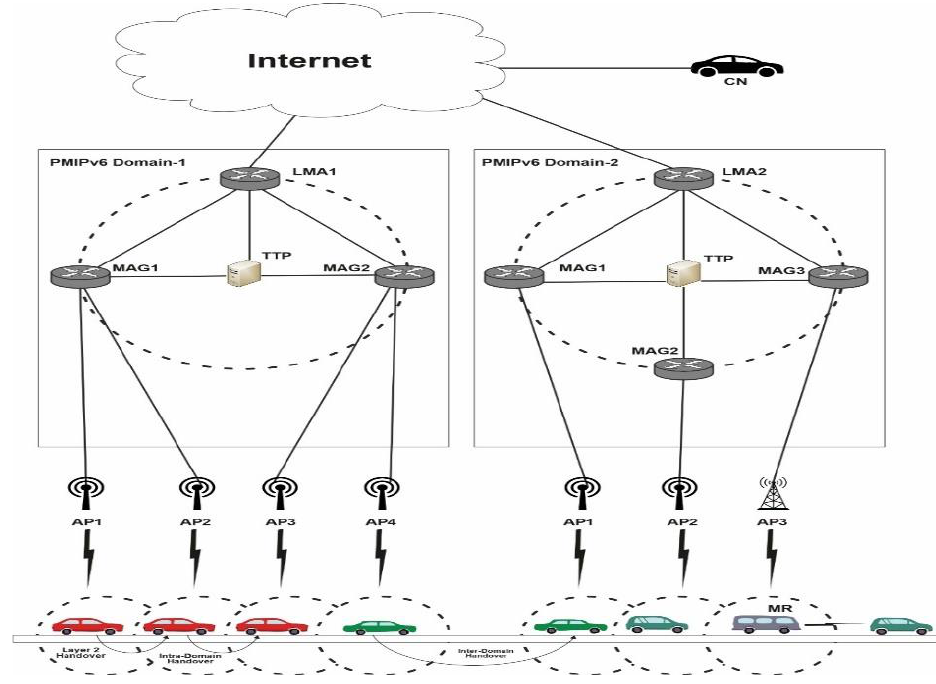
Figure 3. PMIPv6 Architecture in VANET.